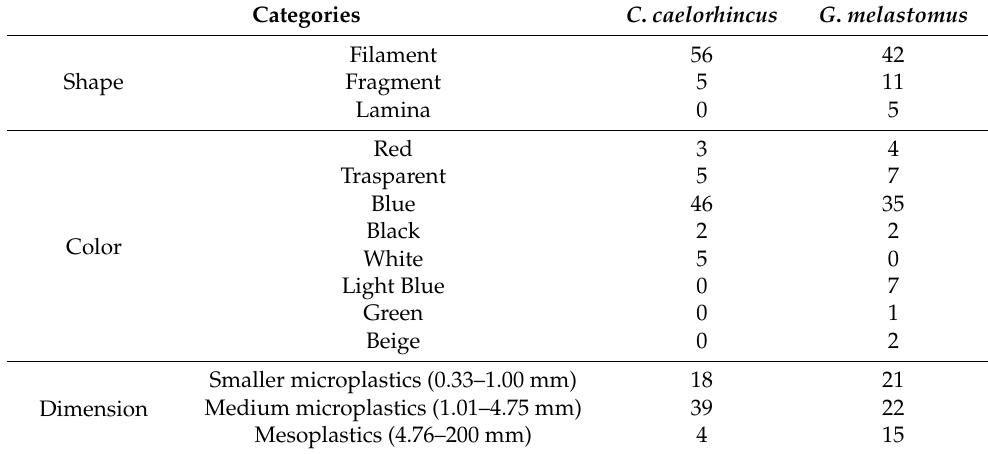
Table 1. Macro and subcategories of microplastics as number of items found in the stomachs of two bottom dwelling opportunistic feeder species from the bathyal plane of the eastern central Tyrrhenian Sea. Categories C . caelorhincus G . melastomus Filament 56 42 Shape Fragment 5 Lamina